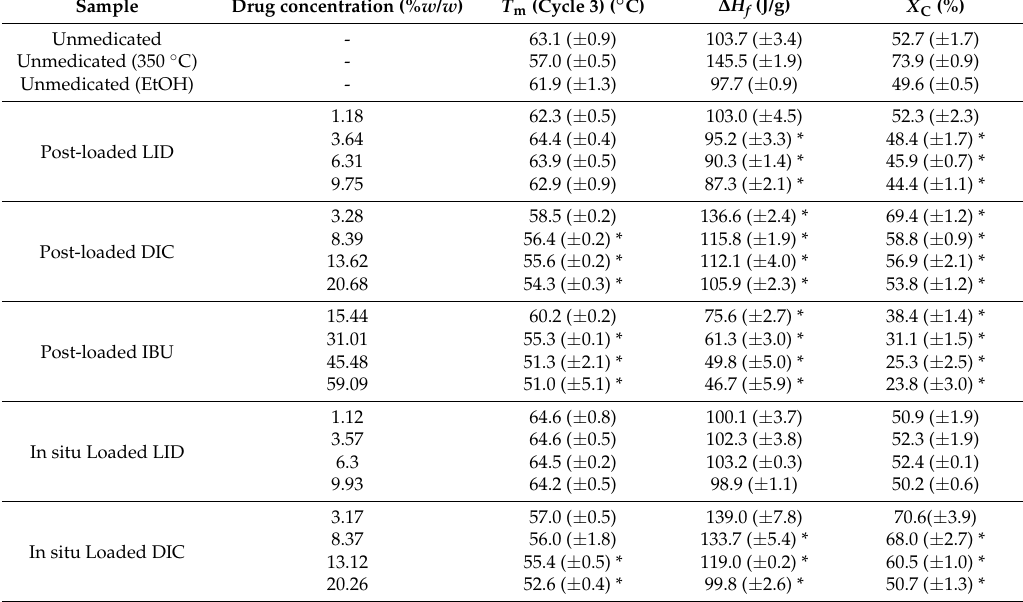
Table 4. Effect of loading method and drug physicochemical properties on the melting temperatures ( T m ) and degree of crystallinity of hydrogel polymeric film. T m and corresponding ∆ H f values were obtained from second heating (cycle 3). Values in brackets indicate the standard deviation from reported mean ( n = 3; * Significantly different from corresponding unmedicated hydrogels Significantly different within groups; p <